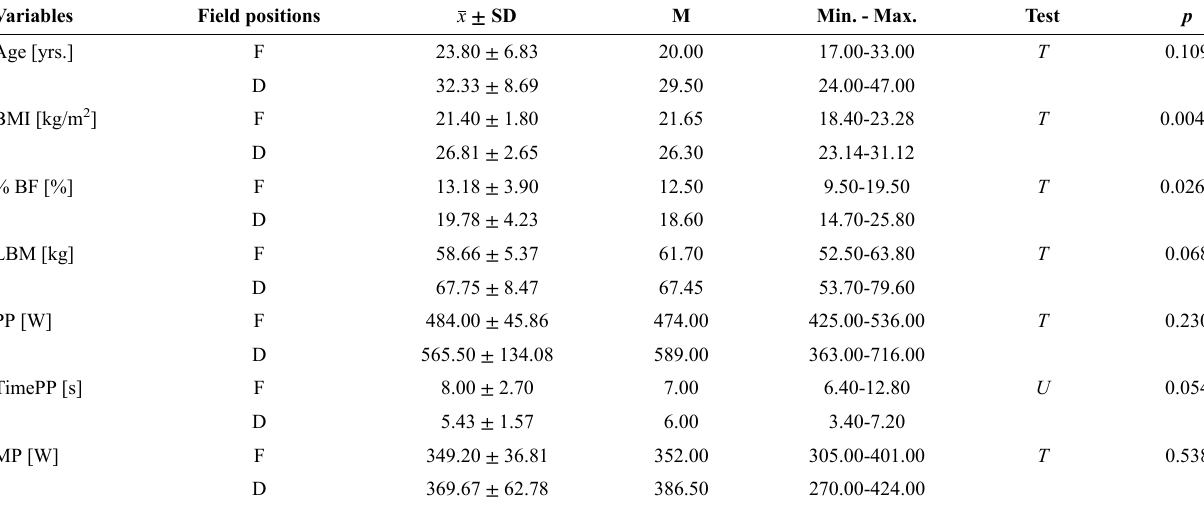
Table 1 - Characteristic of the study group (n = 11) and results of the WAnT and the 20-m sprint test between forwards (n = 5) and defenders (n = 6). Variables Field positions x ± SD M Min. - Max. Age